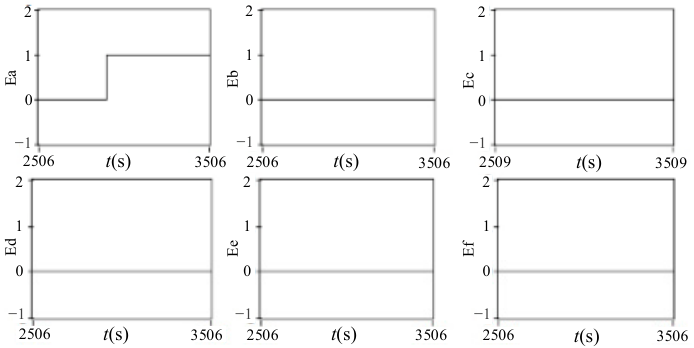
Figure 29. Fault index waveform in case of phase failure of phase a .